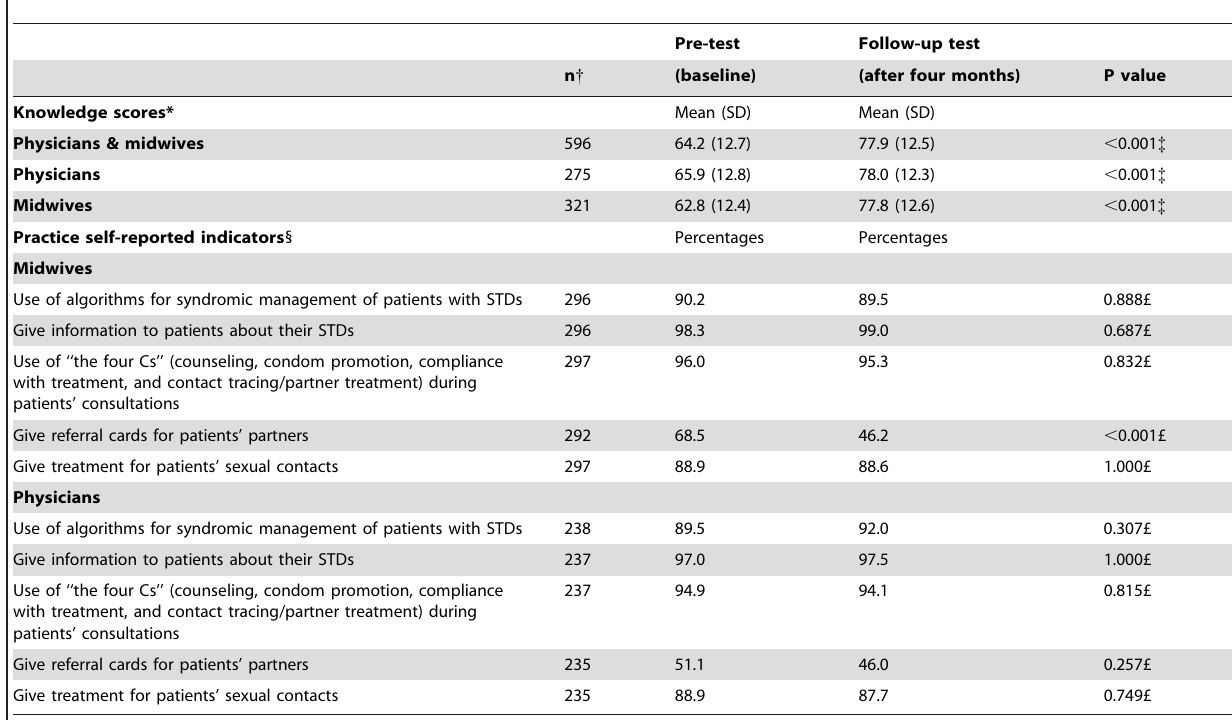
Table 2. Participants’ knowledge scores and self-reported practices of syndromic management of